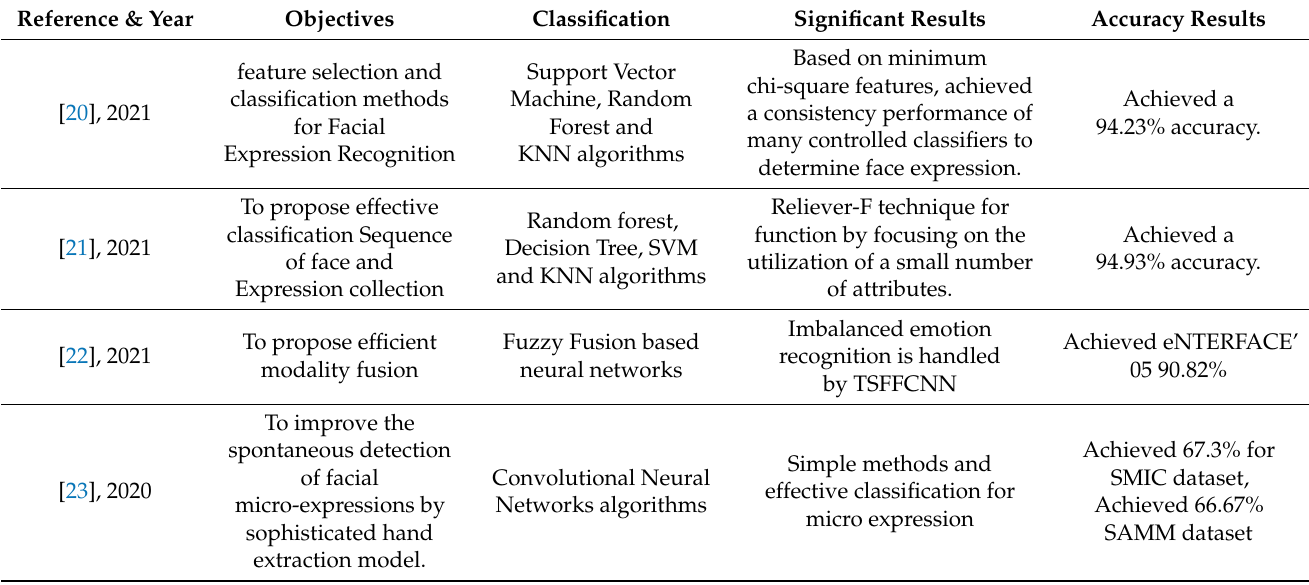
Table 1. Objectives and significant results of existing works.